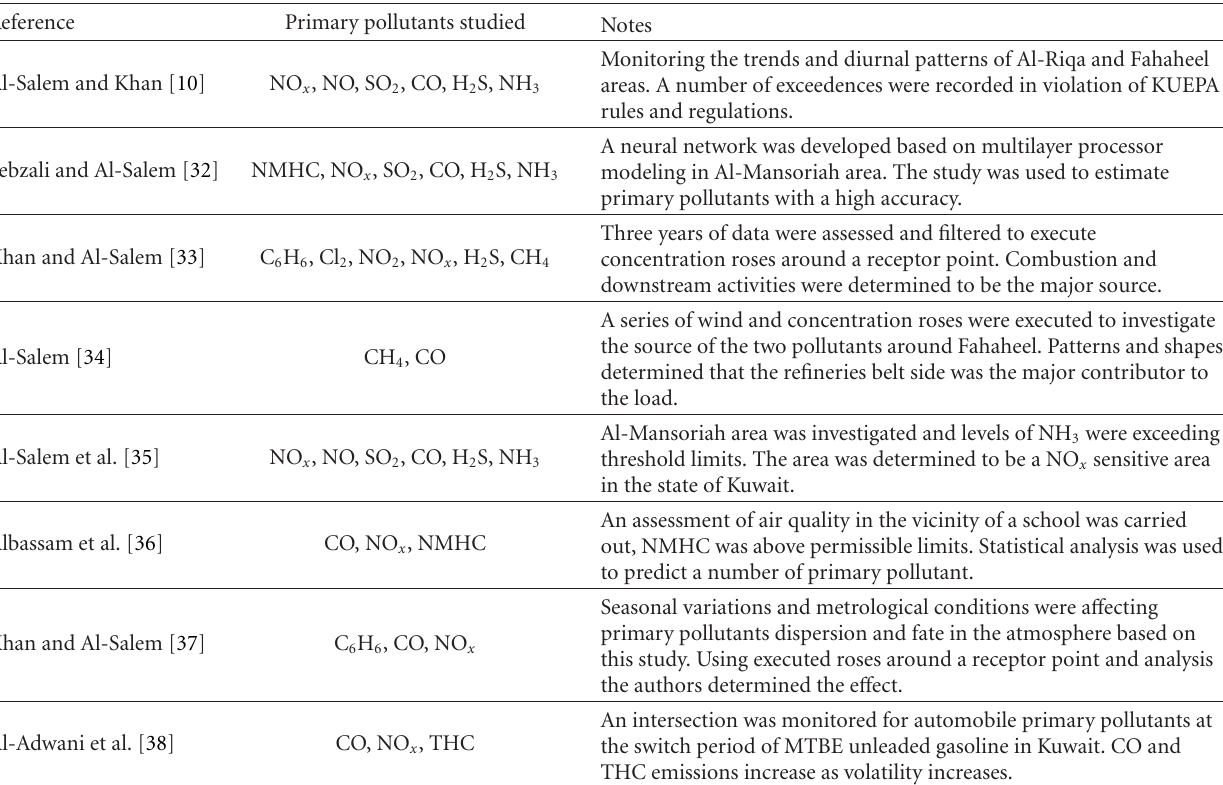
Table 2: Summary of recent studies conducted in the state of Kuwait focused on primary pollutants monitoring and source